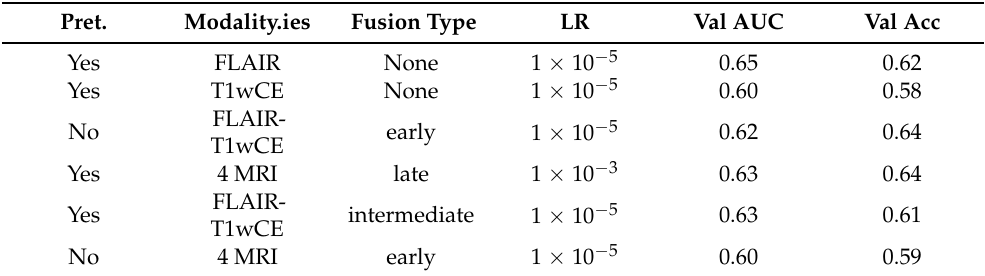
Table 1. Results on the handmade validation set. Pret. stands for Pre-trained; LR for Learning Rate. When fusion type is set to None, it means that we are using unimodal scan and no fusion is needed.